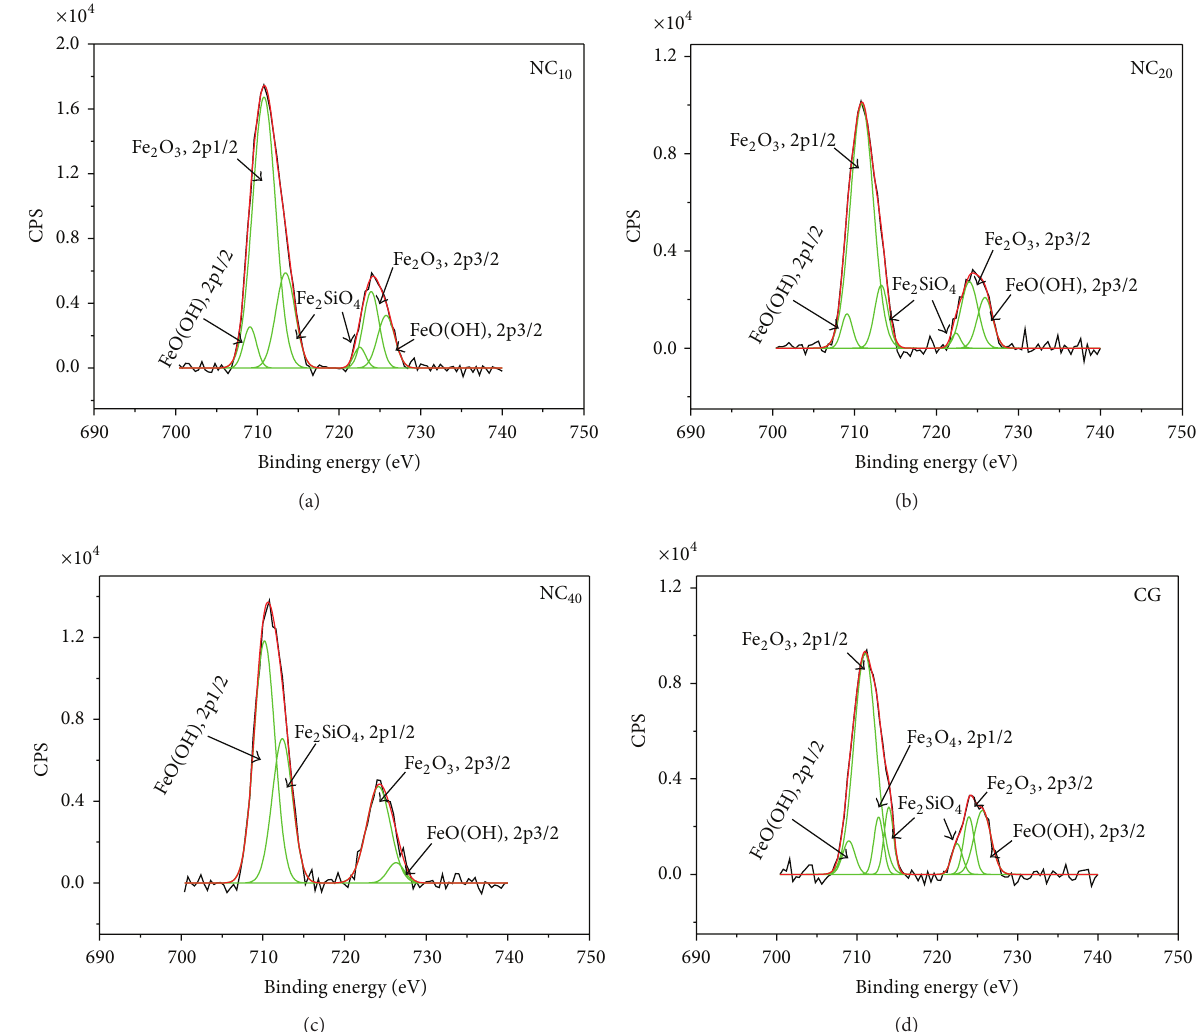
Figure 3: XPS spectra of Fe2p of Fe 88 Si 12 alloy on the worn surfaces at a sliding speed of 0.08